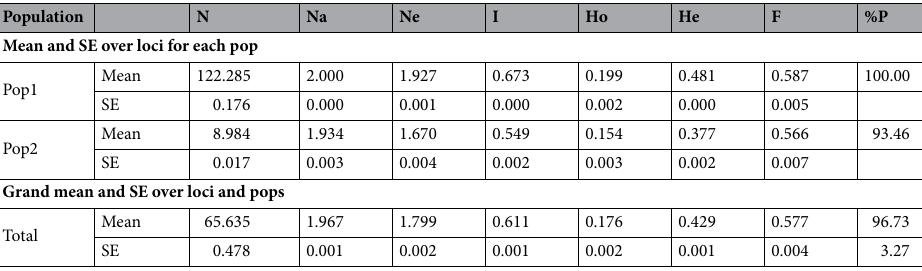
Table 4. Summary of the different genetic diversity parameters used to infer the extent of genetic diversity available in different chickpea sub-populations. N sample size, Na number of different alleles, Ne number of effective alleles, I Shannon’s information index, Ho observed heterozygosity, He expected heterozygosity, %P variation explained, SE standard